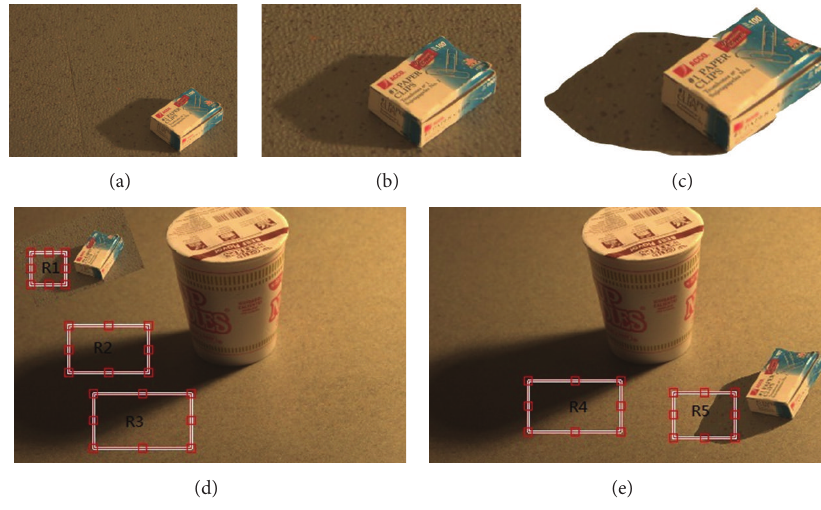
Figure 8: Examples of forged image with shadow.